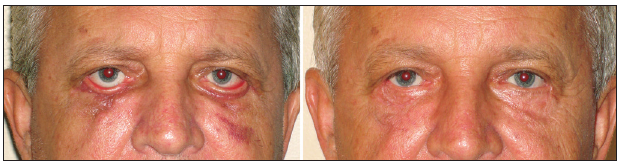
Figure 4. Patient with lower eyelid malpositioning after blepharoplasty caused by ectropion. Below: postoperative picture after correction by means of canthoplasty with the tarsal strip and skin grafting.